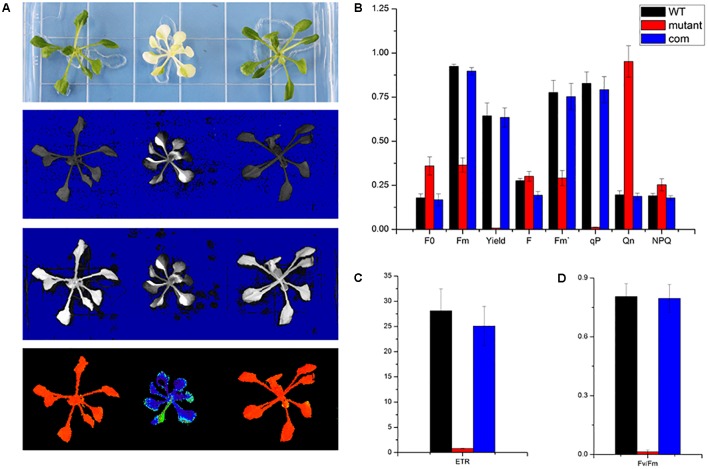
Photosynthetic fluorescence parameters of WT, skl1-8 mutant, and COM.
(A) Fluorescence images of WT, skl1 mutant, and COM. (B) The values of minimum fluorescence (Fo), maximum fluorescence (Fm), and Fo/Fm; effective quantum yields of PS (Yield); photochemical quenching (qP); and quantum yield of regulated energy dissipation (NPQ). (C) Relative electron transport rates (ETRs). (D)
Fv/Fm ratios. The above experiments were repeated three times independently.